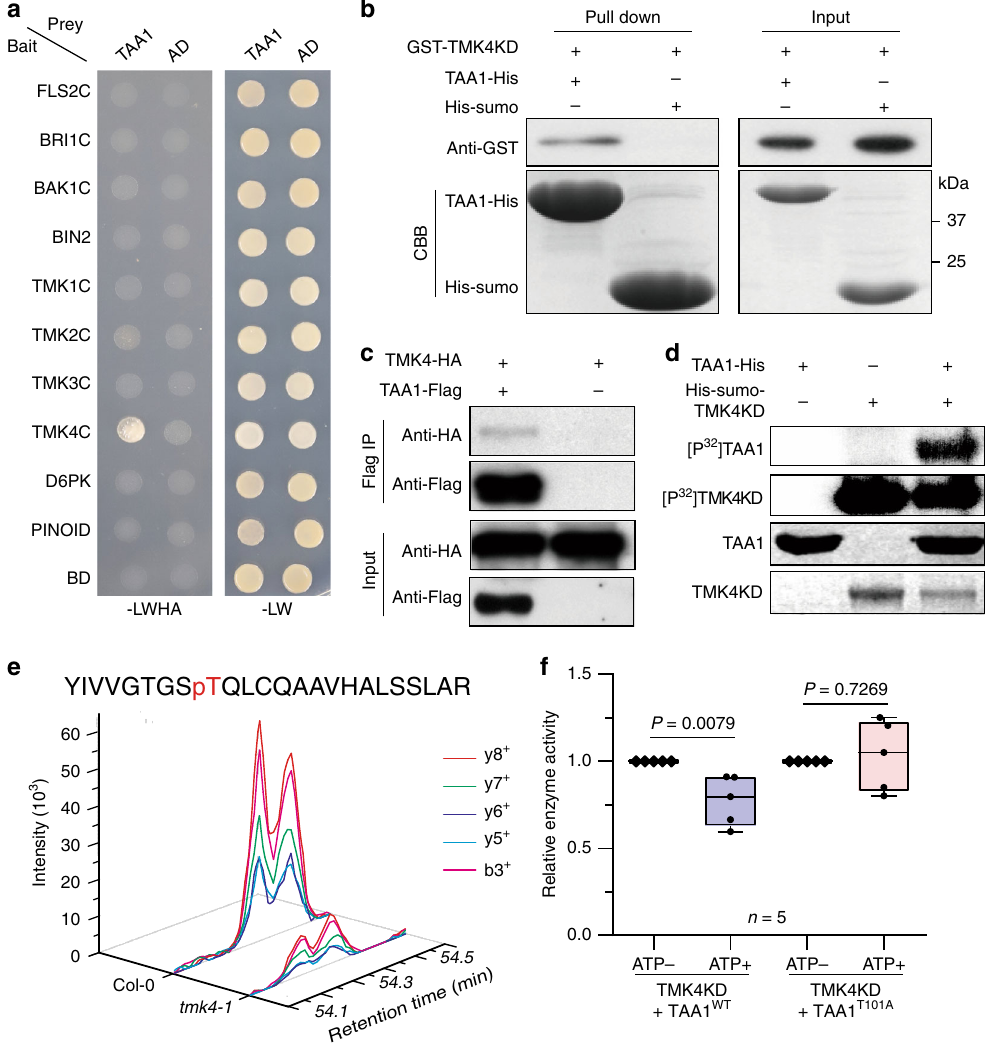
Fig. 3 T101 of TAA1 is targeted by TMK4 kinase. a Yeast two-hybrid assay of multiple protein kinases (bait) and TAA1 protein (prey). Three independent biological repeats. b In vitro pull-down assay showing GST-TMK4 kinase domain (KD) can be pulled down by TAA1-His proteins. His-Sumo proteins were used as a negative control. TMK4 KD was detected via western blot using an anti-GST antibody. TAA1-His and His-Sumo shown by Coomassie blue staining (CBB). Three independent repeats showed similar results. c TMK4 was coimmunoprecipitated with TAA1 in protoplasts. 35S-TMK4-HA and 35S- TAA1-Flag were transiently coexpressed in Arabidopsis protoplasts. Single transformation of 35S-TMK4-HA was used as control. Three independent repeats showed similar results. d In vitro kinase assay of TMK4 kinase domain (KD) on TAA1 protein. Three biological repeats. e Mass spectrometric analysis of the phosphor-peptide intensity in Col-0 and tmk4-1 . The intensity indicates the phosphorylation level of T101 containing phosphor-peptide (93aa – 116aa). Standardization and another two repeats were shown in Supplementary Fig. 10b, c. f Quanti fi cation of TAA1 enzymatic activity with or without TMK4KD phosphorylation. E. coli -puri fi ed His-sumo-TMK4KD and TAA1 proteins were mixed together to perform a phosphorylation reaction triggered by ATP before the in-gel transaminase catalytic reaction (Methods section). ATP + indicated the phosphorylation reaction between TMK4KD and TAA1 with ATP, and ATP − indicated the abolished phosphorylation reaction without ATP. P values were shown as indicated ( n represents fi ve biological repeats); two-sided t -test. Centre line in box represents mean and whiskers show minimum to